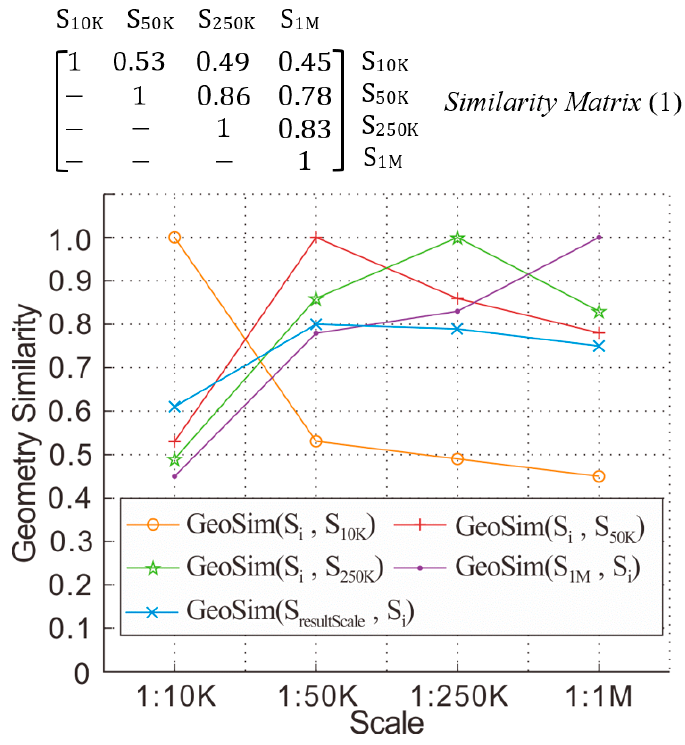
Figure 8. Geometry similarity values between residential areas at four scales.